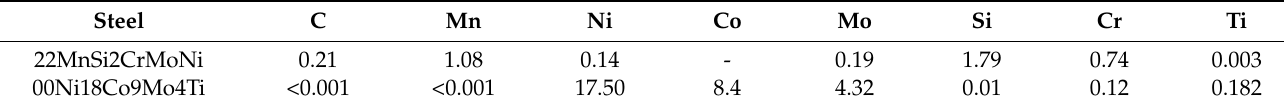
Table 1. Chemical compositions of tested steels (wt.%).